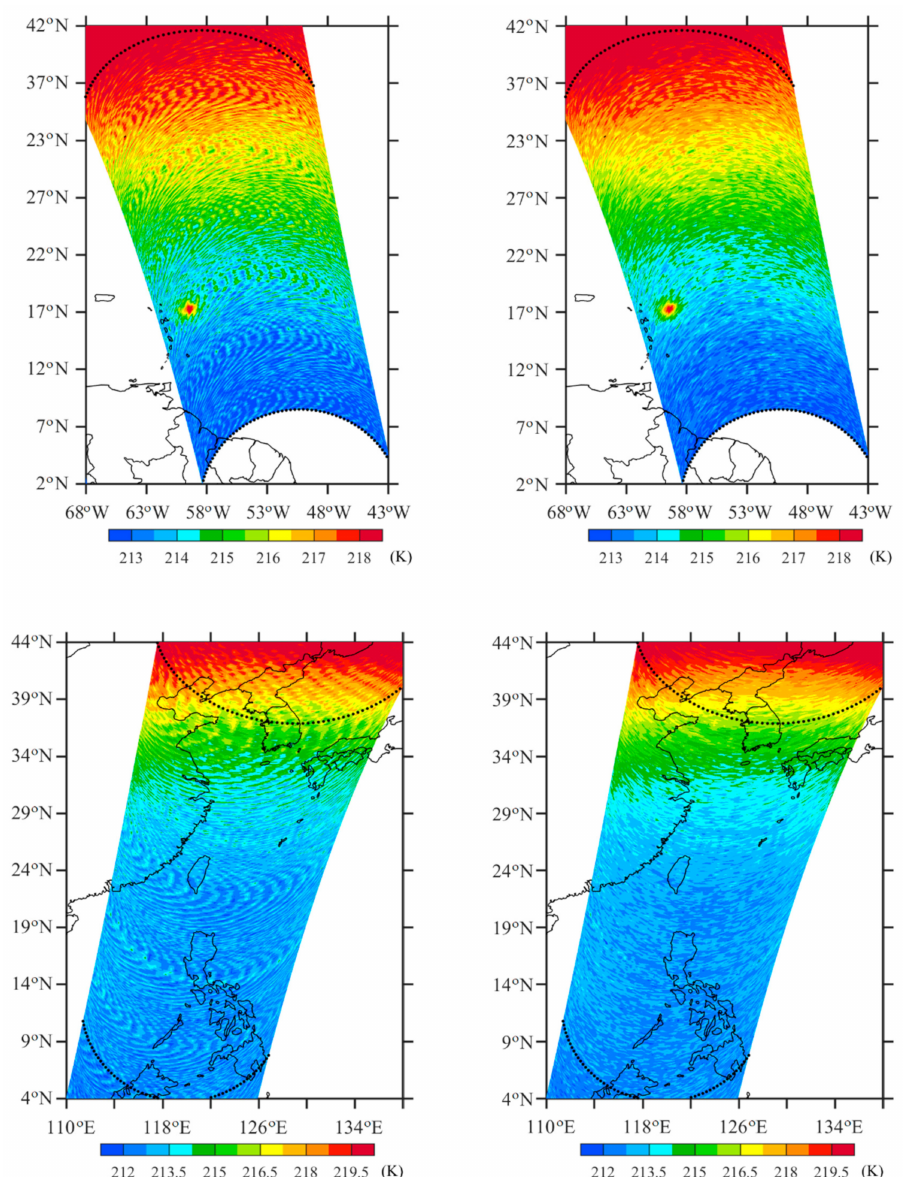
among these three areas.